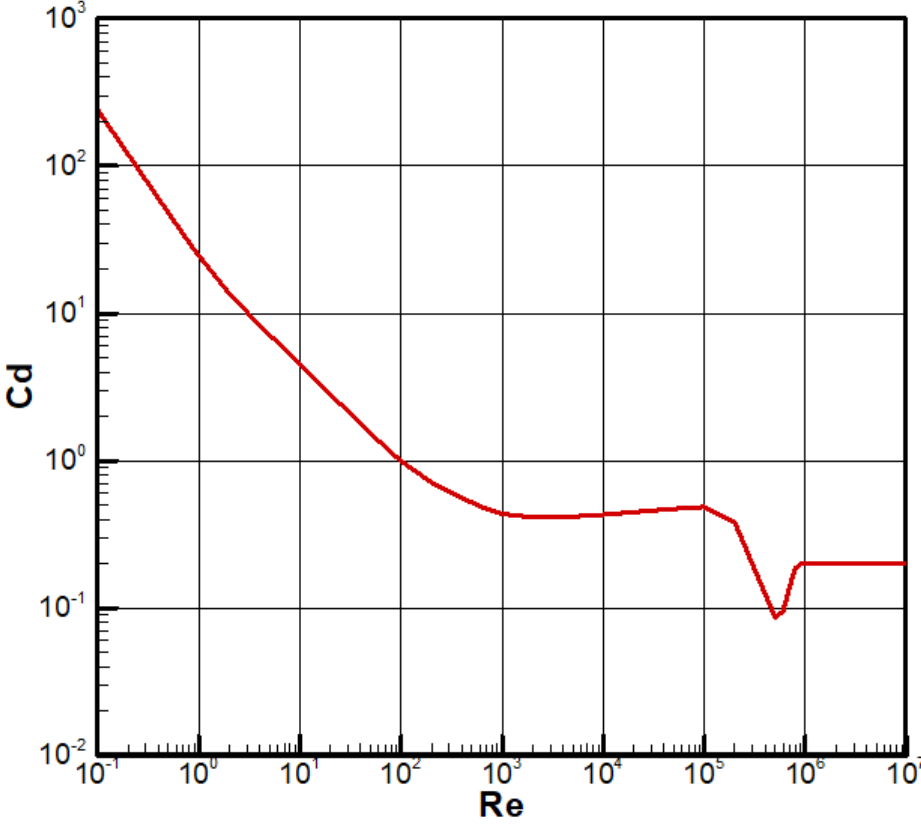
Figure 2. Drag coefficient for the sphere depending on Reynolds